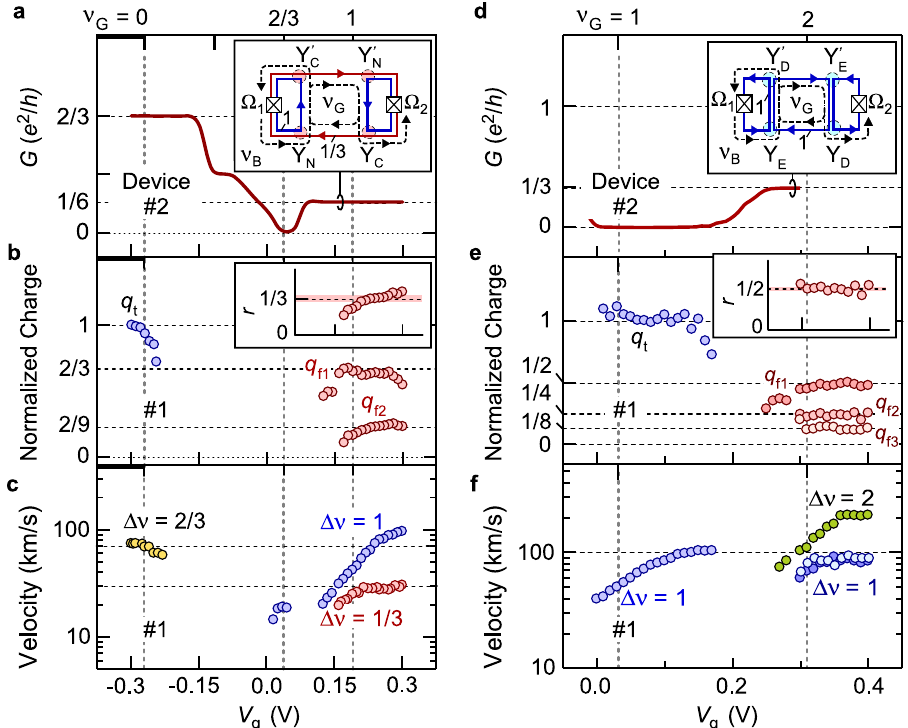
Fig. 3 Characteristics of charge transport. a , d V g -dependence of two-terminal conductance G measured with ohmic contacts Ω 1 and Ω 2 of device #2 obtained at ν B = 2/3 in a and ν B = 1 in d . The insets show the channel con fi gurations, where multiple charge fractionalizations at Y-junctions explain the plateau G = e 2 /6 h at ν G = 1 in a and G = e 2 /3 h at ν G = 2 in d . b , e The reference charge q t , and fractionalized charges q f1 , q f2 , and q f3 in the respective packets normalized by q t . A single reference packet typically involves q t ffi 240 e in b and 30 e in e . The clear plateaus of q f / q t indicate the quantized fractionalization. The insets show fractionalization facto r r = q f2 / q f1 with a constant region ( r = 0.34 ± 0.03 in b and r = 0.49 ± 0.03 in e ). c , f Charge velocities of the channels. The Δ ν = 1/3 interface channel between ν = 1 and 2/3 regions, the Δ ν = 1 edge channel between ν G = 1 and vacuum, and the Δ ν = 2/3 composite channel between ν = 0 and ν = 2/3 are shown in c , whereas the Δ ν = 1 interface channel between ν = 2 and ν = 1 regions (0.3 G B G B V < V g < 0.4 V , estimated from the second and the third packets), the Δ ν = 1 edge channel between ν G = 1 and vacuum ( V g < 0.18 V), and the Δ ν = 2 composite channel between ν G = 2 and vacuum are shown in f . Data in b , c , e , and f were obtained using device #1. Vertical dotted lines for representative ν G values were determined from a separate four-terminal measurement (see Supplementary Note